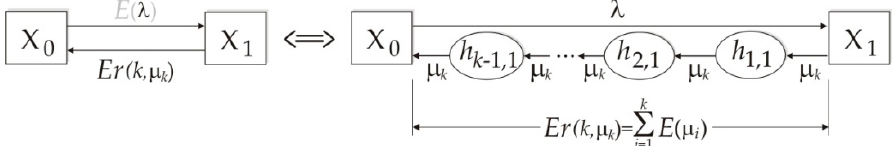
Figure 3. Process of Markovization of the elementary birth–death process based on the abstract hidden Markov states (HMS) and the convolution of the exponential distribution.